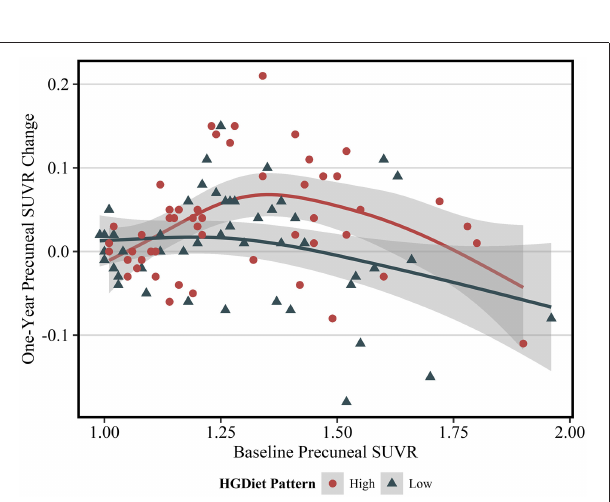
FIGURE 4 | Scatterplot of 1 year change in PET SUVR values as a function of baseline PET SUVR in the precuneus region. The fit lines represent regression estimated means for categorical HGDiet pattern intake determined by a median split (High vs. Low). 1-year change in precuneal amyloid SUVR varied depending upon baseline amyloid SUVR values where those with moderately elevated amyloid status at baseline had the highest rate of amyloid accumulation over 1 year. HGDiet pattern adherence appeared to explain some of the variance in amyloid accumulation as a function of baseline levels with high HGDiet exhibiting an inverted U shape for rate of amyloid accumulation peaking higher than the more linear, downward trending fitment line for low HGDiet. Shaded areas are 95% confidence